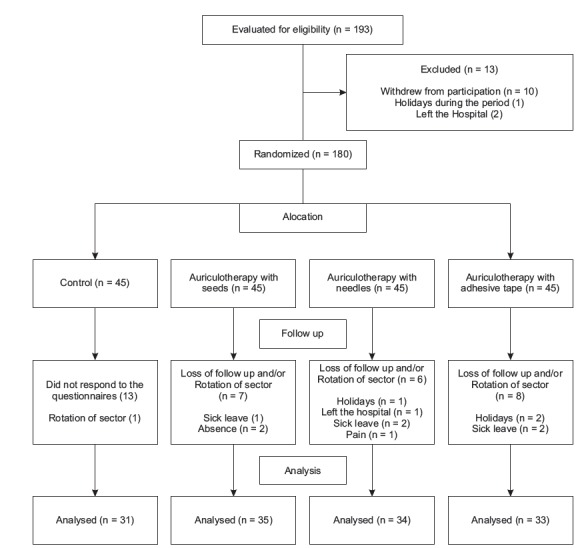
Flowchart of participants involved in the study. São Paulo, SP, Brazil,
2016